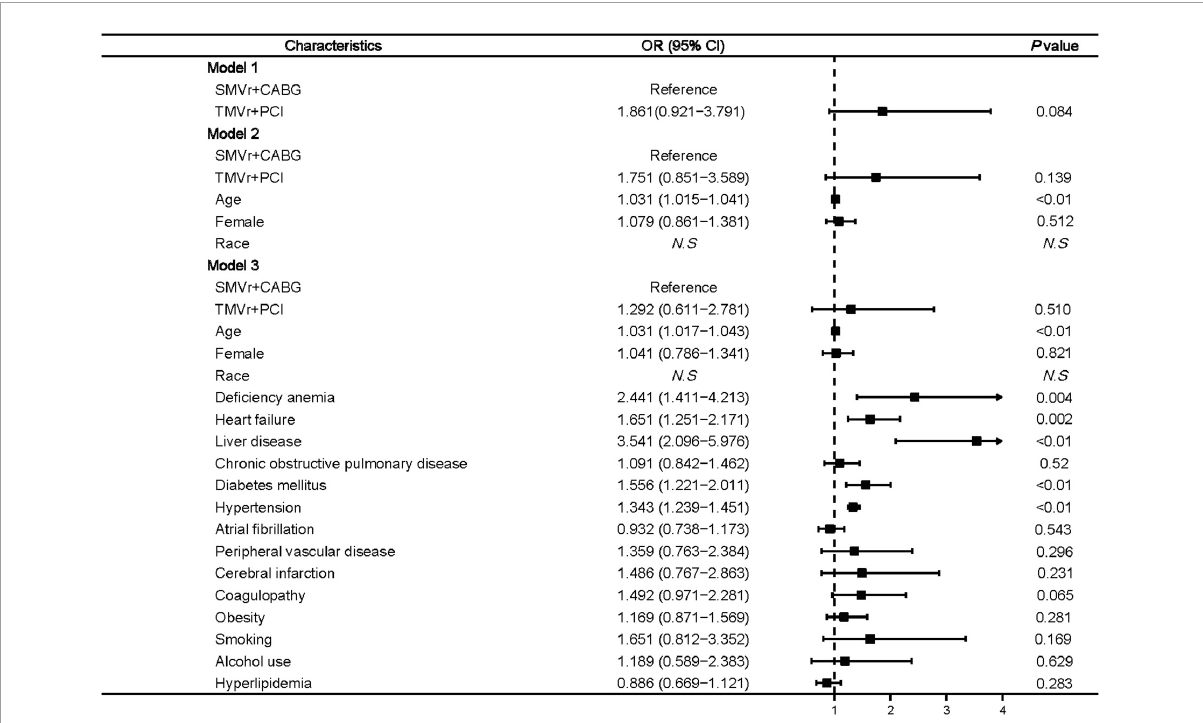
FIGURE5 Predictors of post-procedural acute kidney injury in mitral valve insufficiency patients undergoing SMVr + CABG or TMVr + PCI. TMVr indicates transcatheter mitral valve repair; SMVR indicates surgical mitral valve repair; CABG indicates coronary artery bypass grafting; PCI indicates percutaneous coronary stent implantation; model 1 indicates the univariate regression analysis; model 2 adjusted for SMVr + CABG, TMVr + PCI, age, female, race; model 3 adjusted for SMVr + CABG, TMVr + PCI, age, female, race, deficiency anemia, heart failure, liver disease, chronic obstructive pulmonary disease, diabetes mellitus, hypertension, atrial fibrillation, peripheral vascular disease, cerebral infarction, coagulopathy, obesity, smoking, alcohol use, and